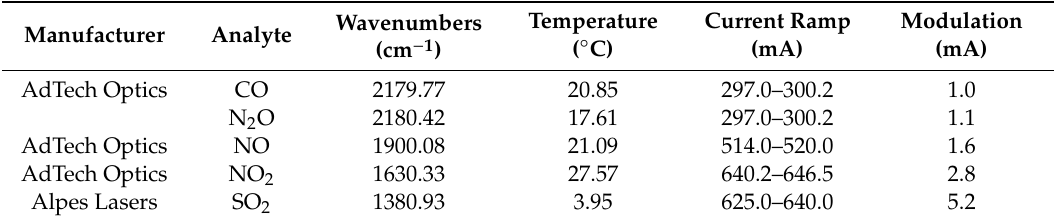
Table 1. Laser parameters used for 2f-Wavelength Modulation Spectroscopy (2f-WMS). The amplitudes of the sine wave modulation were adjusted to achieve the maximum lock-in amplifier signal, according to [46].